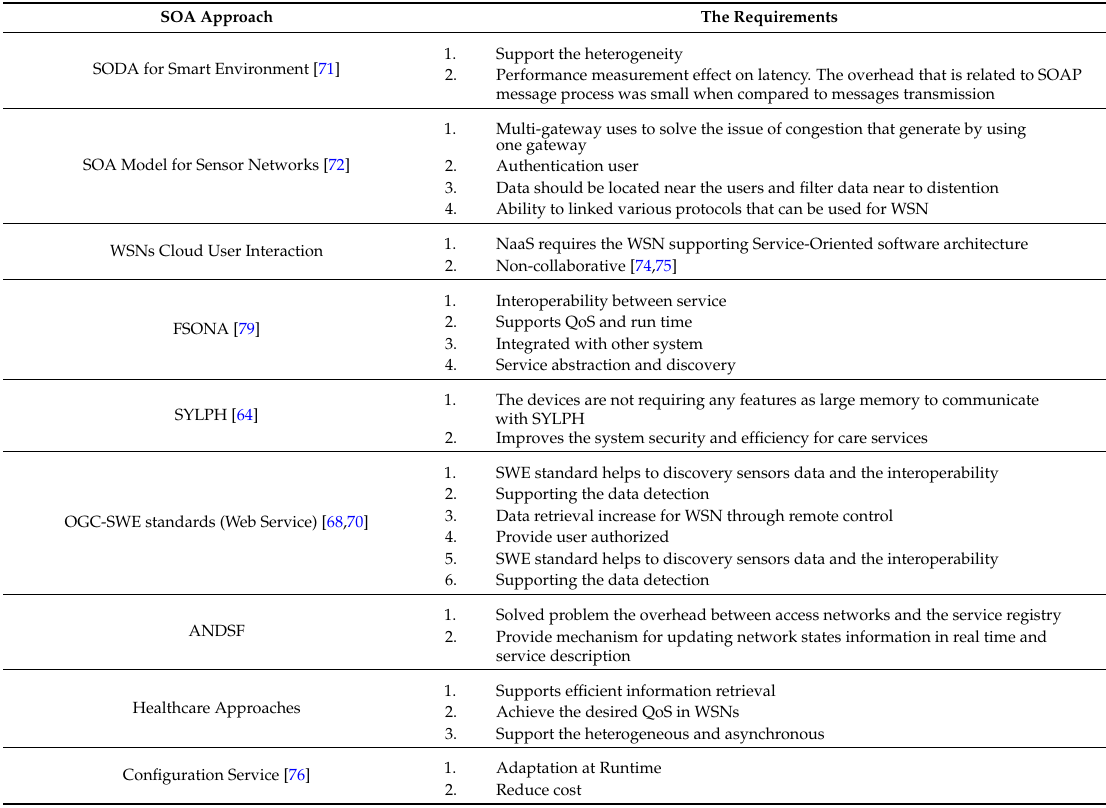
Table 7. The Requirements and Benefits of Applied SOA for